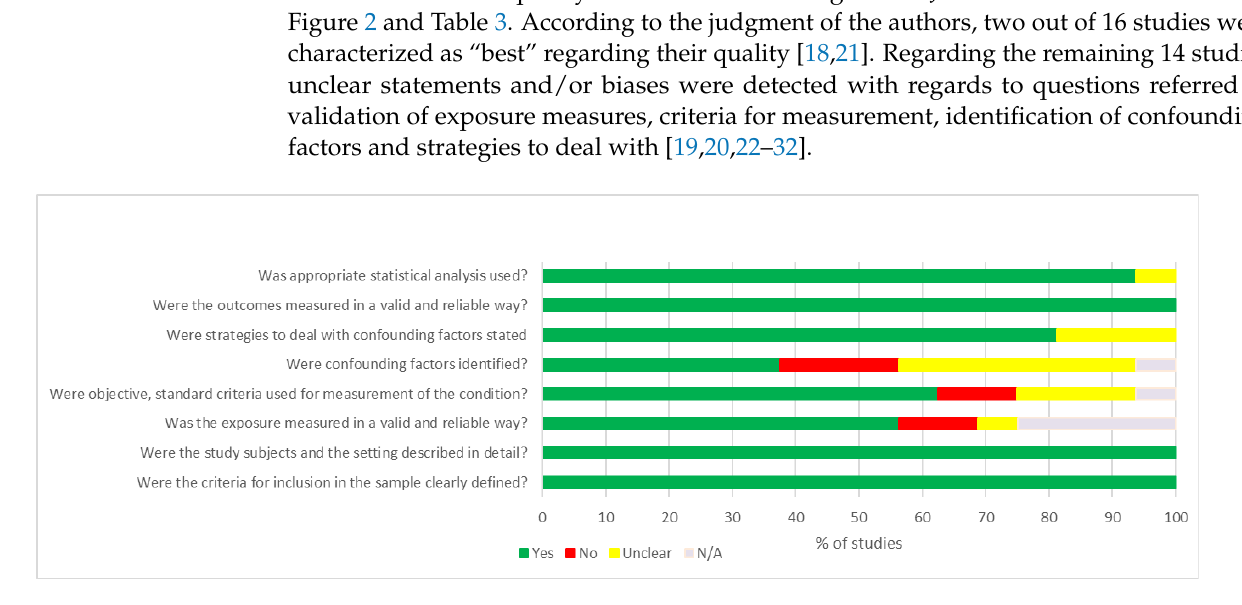
Green: YES, Red: NO, Yellow: Unclear, White: Not applicable.